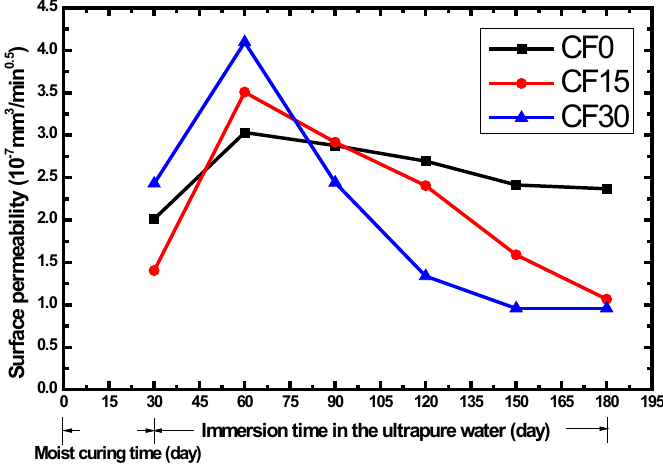
Figure 3. The effect of fly ash on surface permeability coefficient of